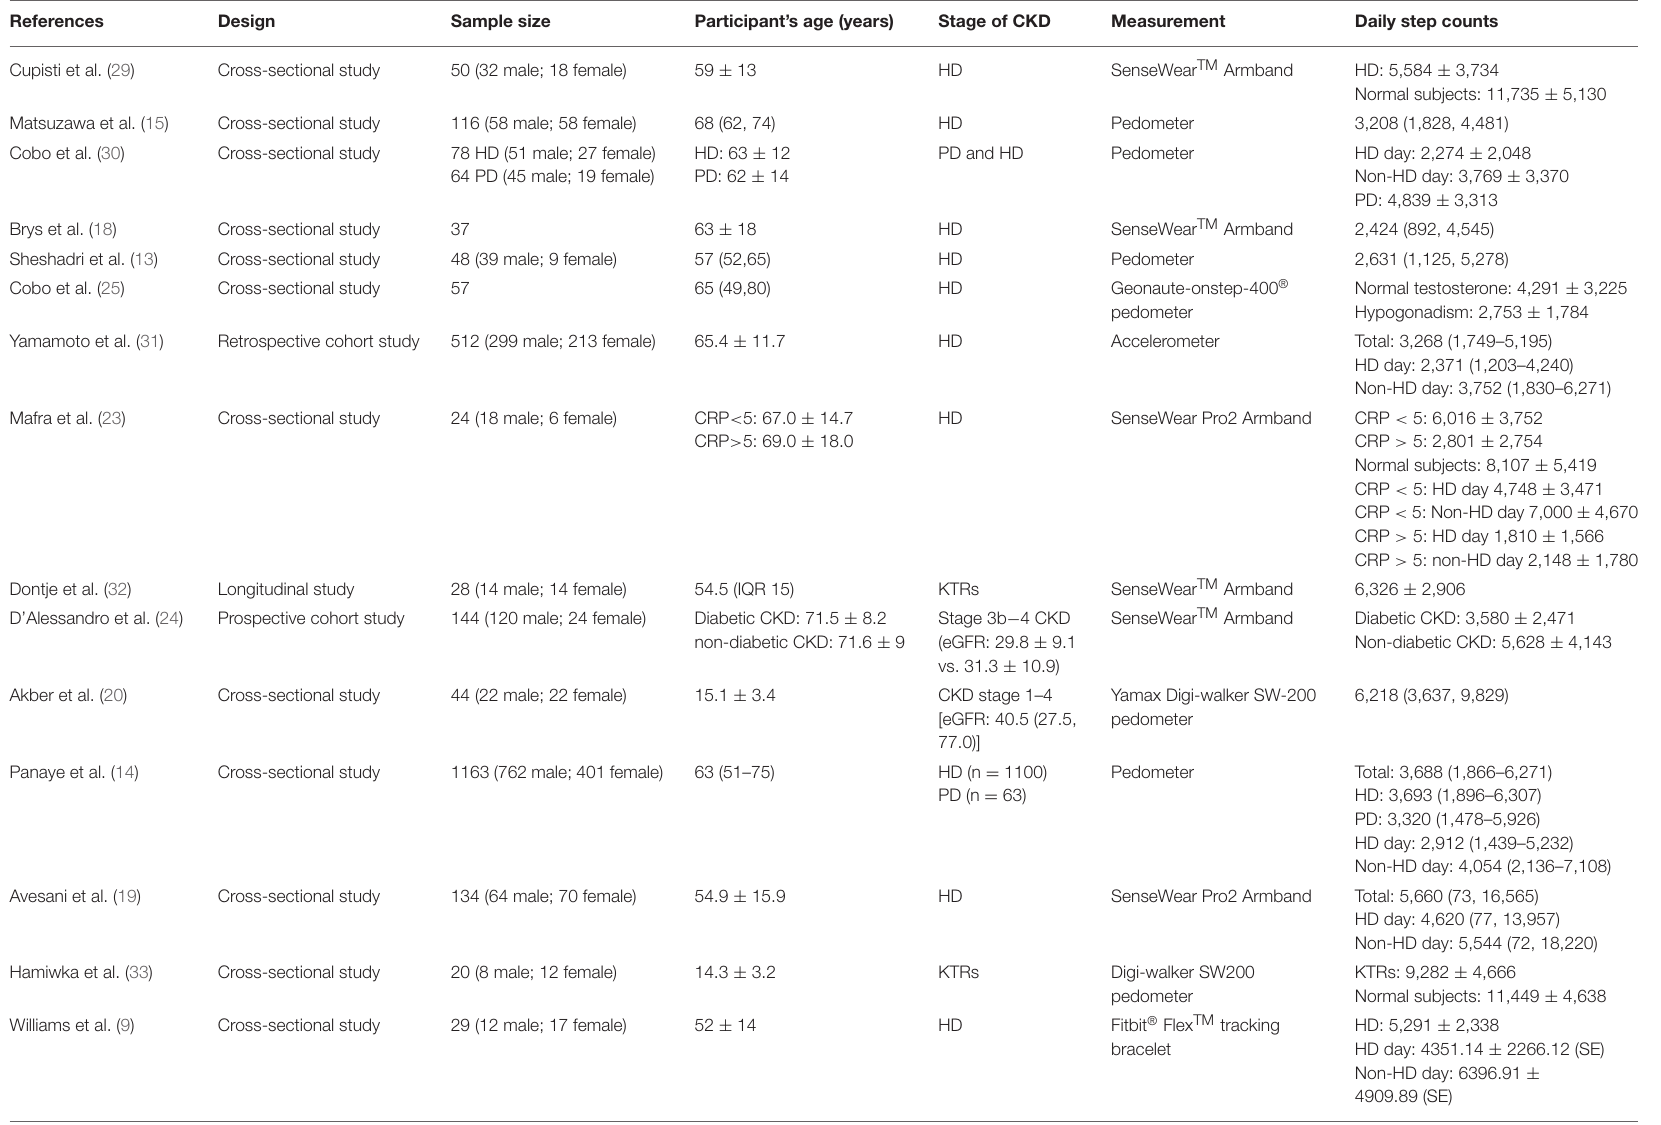
TABLE 1 | Characteristic of observation studies included in the